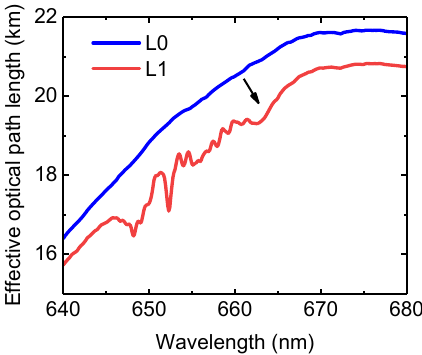
Figure 9. Example of the influence of sample composition of effective absorption optical path length: no extinction (L0) and extinction from 55.6 pptv NO 3 , 11.5 ppbv NO 2 , and 0.8% H 2 O (L1). The NO 3 retrieved by OP-IBBCEAS under different H 2 O mixing ratios is shown in Figure 10a. The green and red points represent the retrieved NO 3 data with and without H 2 O cross-section correction. The averaged H 2 O mixing ratios measured by the humidity sensor were 0.01%, 0.78%, 1.3%, and 1.8% (RH = 0.4%, 30%, 50%, and 70% at 22 ◦ C), respectively. The red and green points agreed well when the chamber was dry. When H 2 O was added, the difference between using the effective H 2 O cross section and the